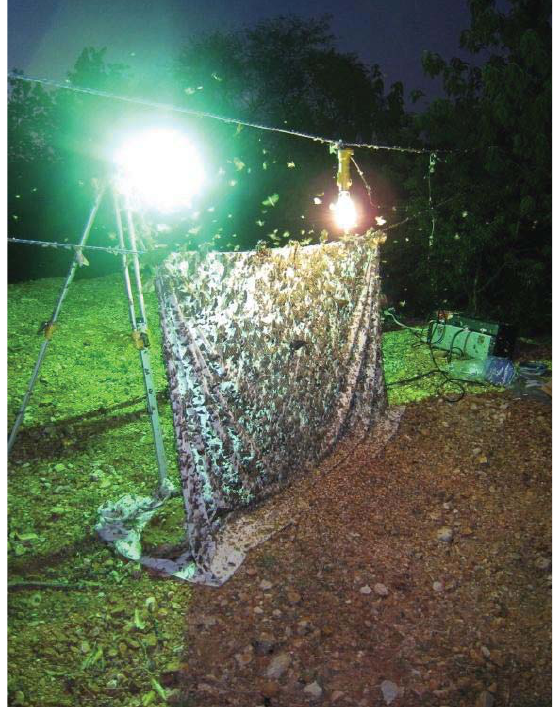
Figure 2. A good night mothing in Sonora. Moths of every description blanket the collecting sheet and their combined weight is starting to collapse the